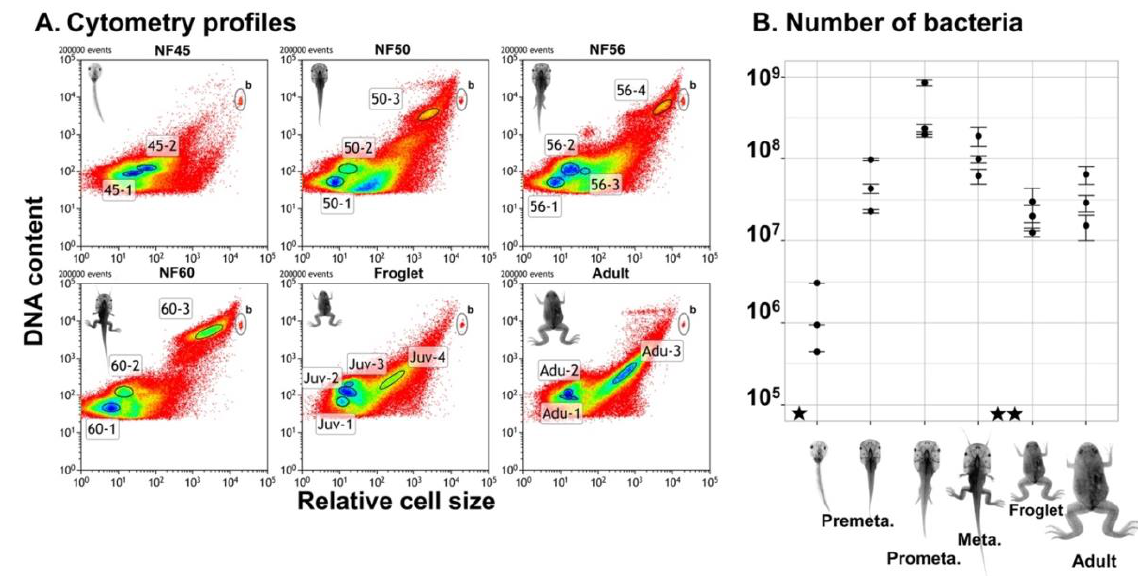
Figure 1. Cytometric profiles of gut bacteria during Xenopus tropicalis development. A. Cytometric profiles. Each dot in the plot represents one event (i.e. a cell), the color represents the density of overlapping point from red (low) to blue (high). The vertical axis represents DNA content by the measurement of propidium iodide (PI) fluorescence (614/20nm) and the horizontal axis represents relative cell size by the measurement of forward scatter. Different bacterial populations are highlighted by an ellipse and identified by a text label. Top- right events labelled with a “b” correspond to the beads used for normalization. Background signals have been removed. B. Enumeration of bacterial load during development. The vertical axis represents the number of bacteria and the horizontal axis corresponds to different stages of development. Each dot corresponds to a biological replicate, the error bar represents the standard deviation obtained by technical replicates. A ★ marks the beginning of feeding and ★★ marks the change from the tadpole to the adult